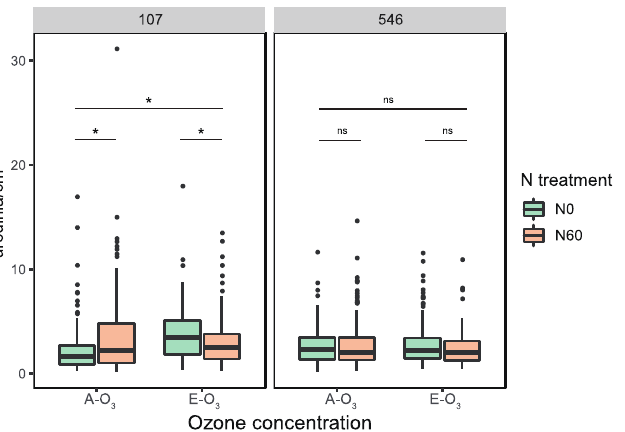
Figure 1. Rust severity of poplar foliar rust in four ambient ozone concentration FACE plots (A ‐ O 3 ) and four elevated ozone concentration FACE plots (E ‐ O 3 ) under two N treatments (N0 = no addition of nitrogen, N60 = addition of 60 kg/ha nitrogen every month). The significant differences between treatments at the 0.05 probability were indicated as the asterisk (*) according to the two ‐ tailed Wil ‐ coxon test; ns: not significant.